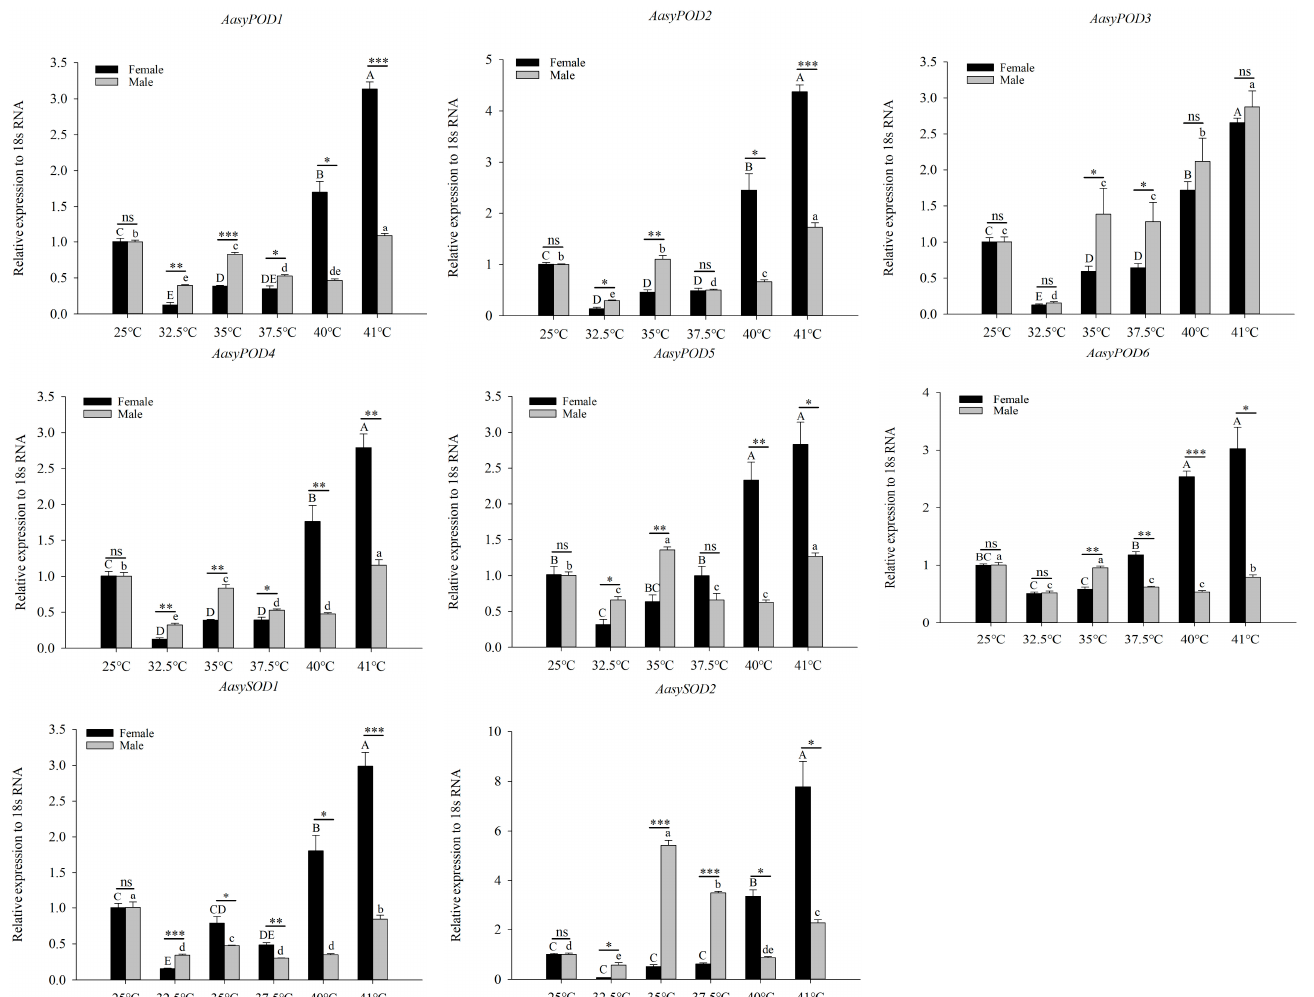
Figure 3. The effect of short-term heat treatment on the relative expression of Aphelinus asychis antioxidant enzyme genes. Each value represents the mean ( ± SE) of three replications. Uppercase and lowercase letters indicate significant differences between adult females and males treated at different temperatures ( p < 0.05). “*”, “**” and “***” mean significant differences between female and male adults at each temperature treatment, respectively ( p < 0.05, p < 0.01 and p < 0.001); “ns” means no significant differences between two columns at each temperature